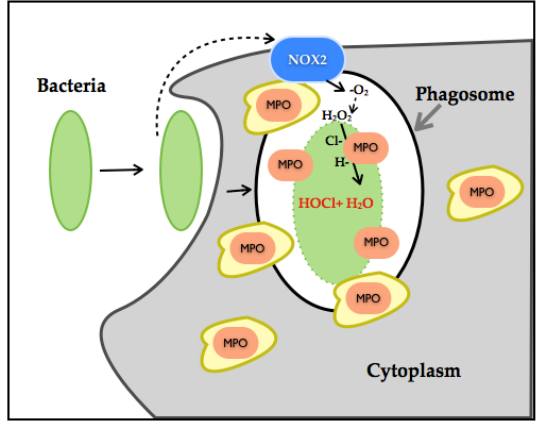
Figure 4. Illustration of neutrophil NOX-HOCl production. Neutrophils have phagosomes and granules in its cytoplasm. Granules contain myeloperoxidase (MPO) (orange). The NOX2 complex (blue) gets assembled once the neutrophils initiate bacterial endocytosis. NOX2 produces H 2 O 2 by dismutation, and MPO reacts with H 2 O 2 and chloride ions, thereby generating HOCl and water, leading to neutrophil bactericidal